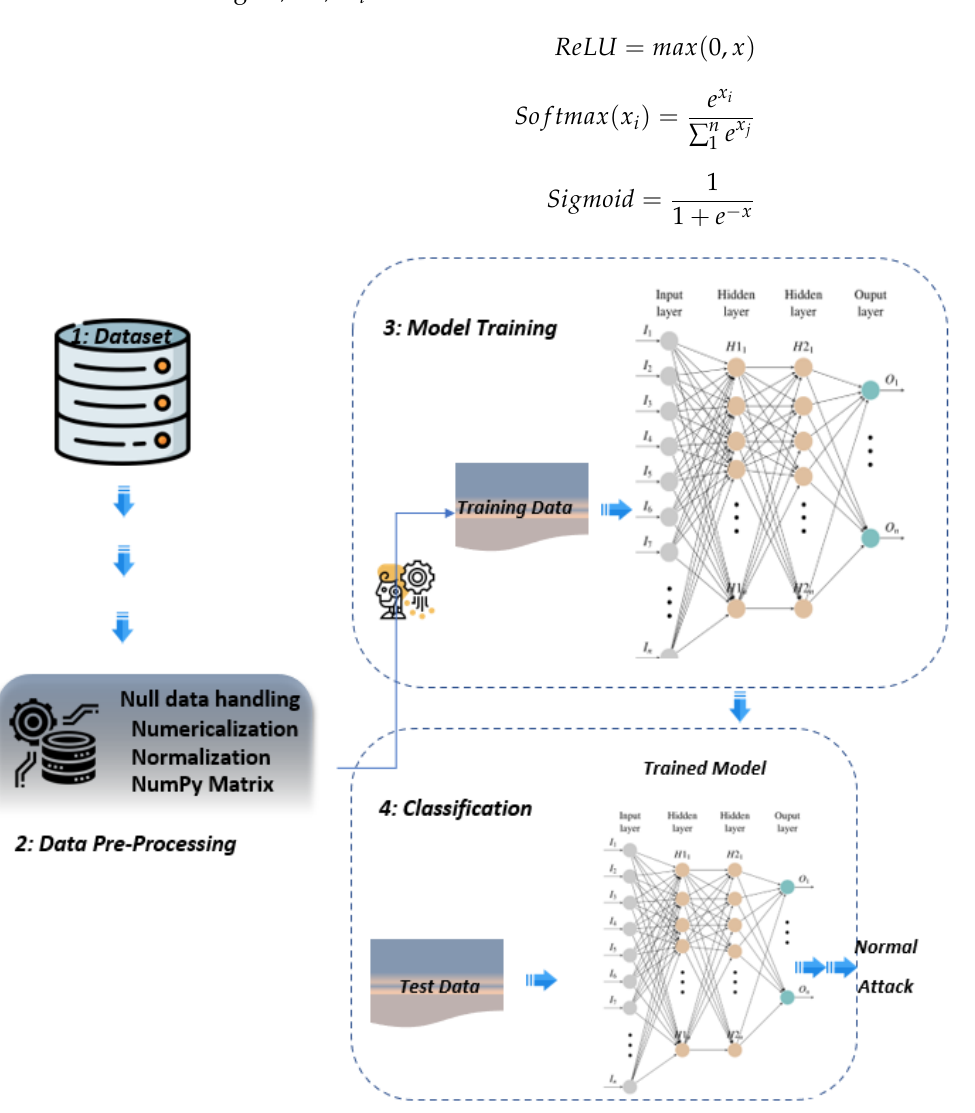
Figure 3. Proposed IDS